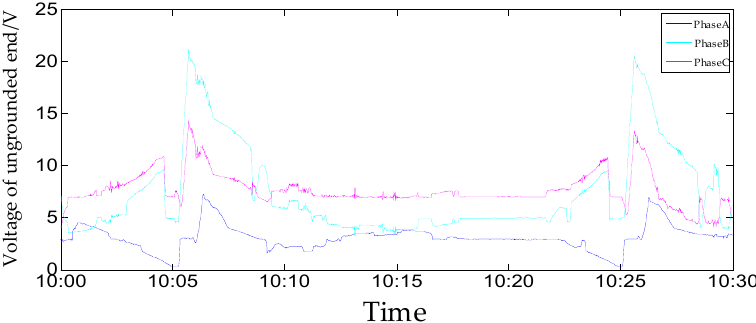
Figure 11. “Hukun 1” induced voltage at the ungrounded end of the cable sheath.